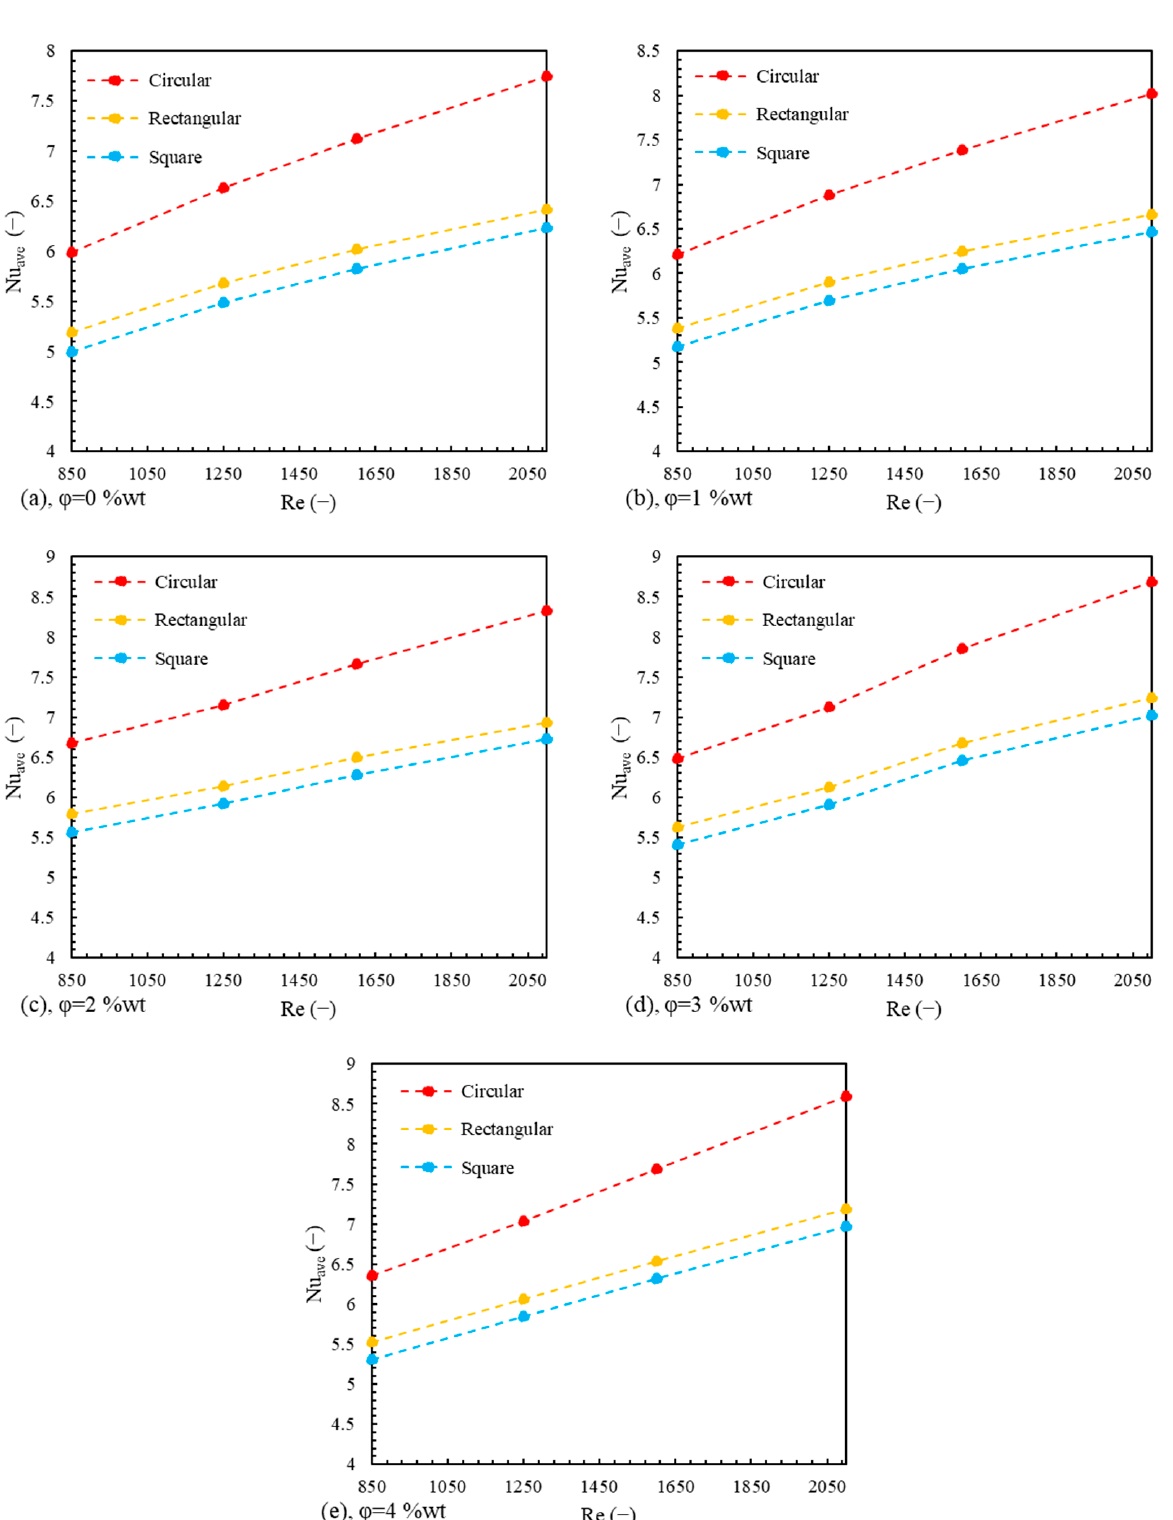
Figure 12. The average Nu number in all cross-sections within a range of Re numbers for ( a ) water, ( b ) nanofluid with 1% concentration, ( c ) nanofluid with 2% concentration, ( d ) nanofluid with 3% concentration, and ( e ) nanofluid with 4% concentration.